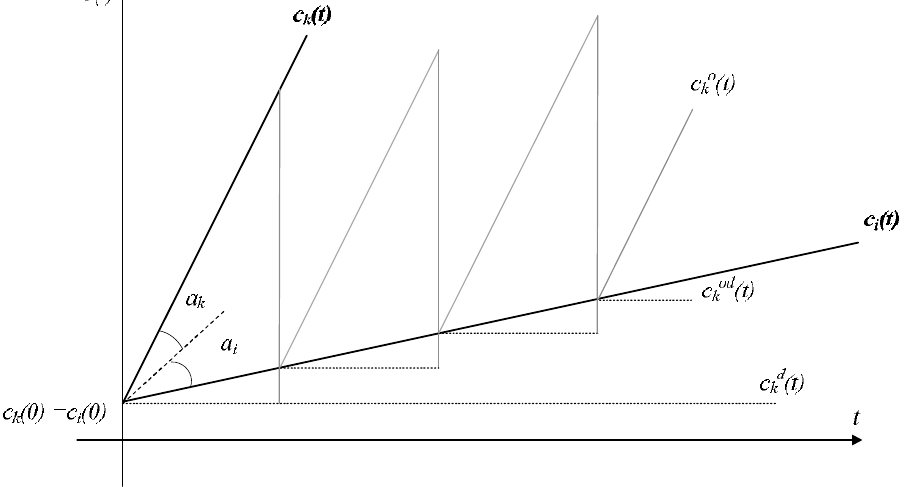
Figure 3. Clock difference by local clock